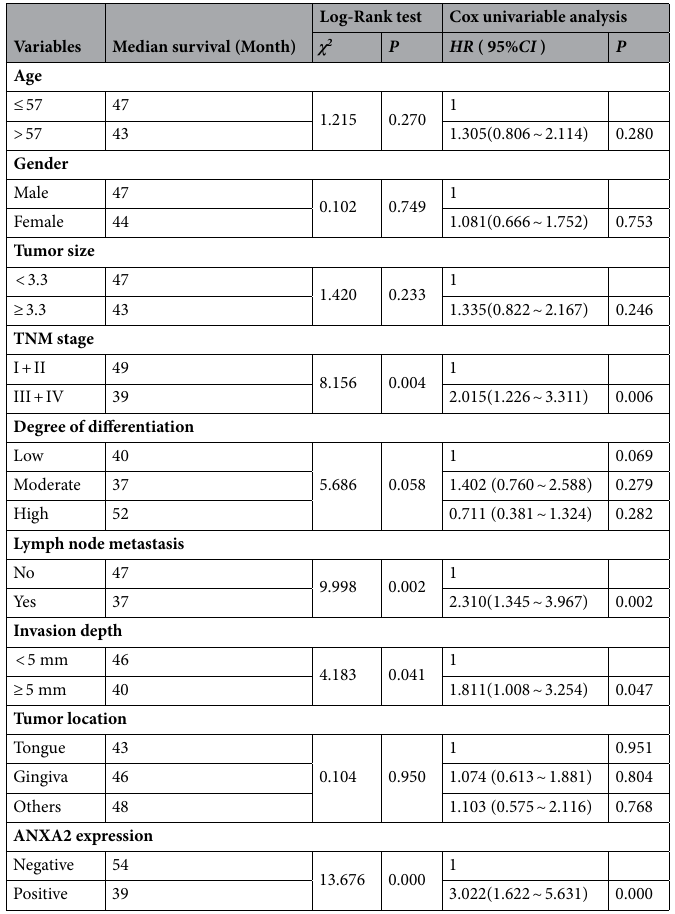
Table 2. Kaplan–Meier and univariate analysis of all parameters in patients with OSCC.